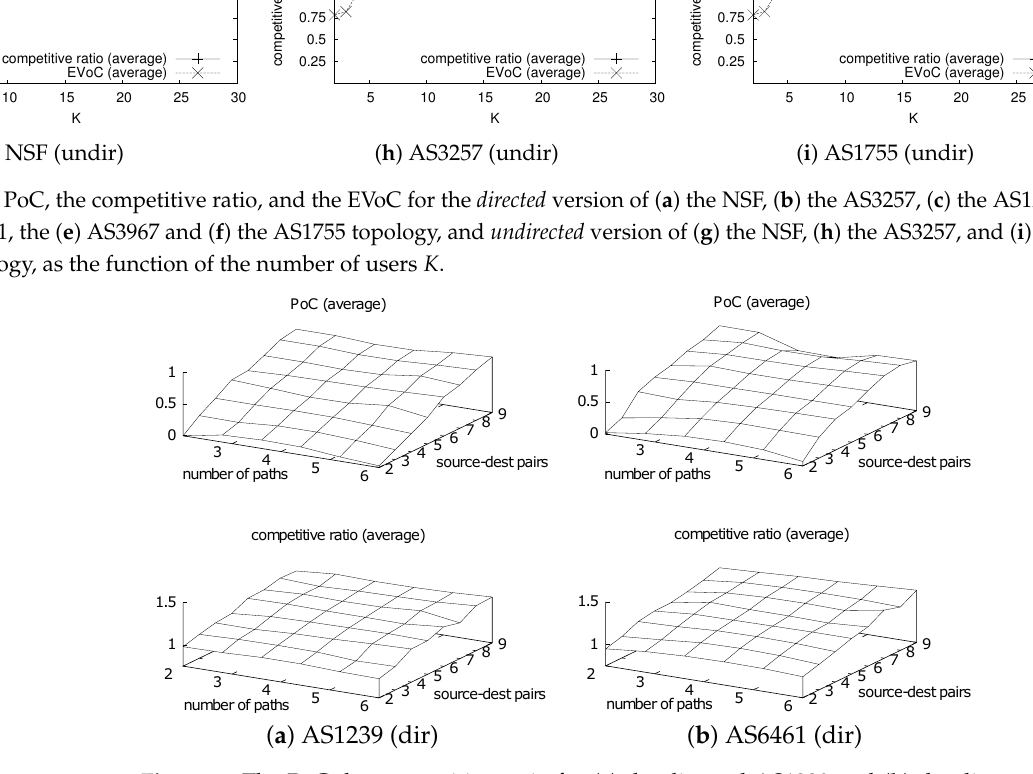
Figure 4. The PoC the competitive ratio for ( a ) the directed AS1239 and ( b ) the directed AS6461 topology, as the function of the number of users and number of